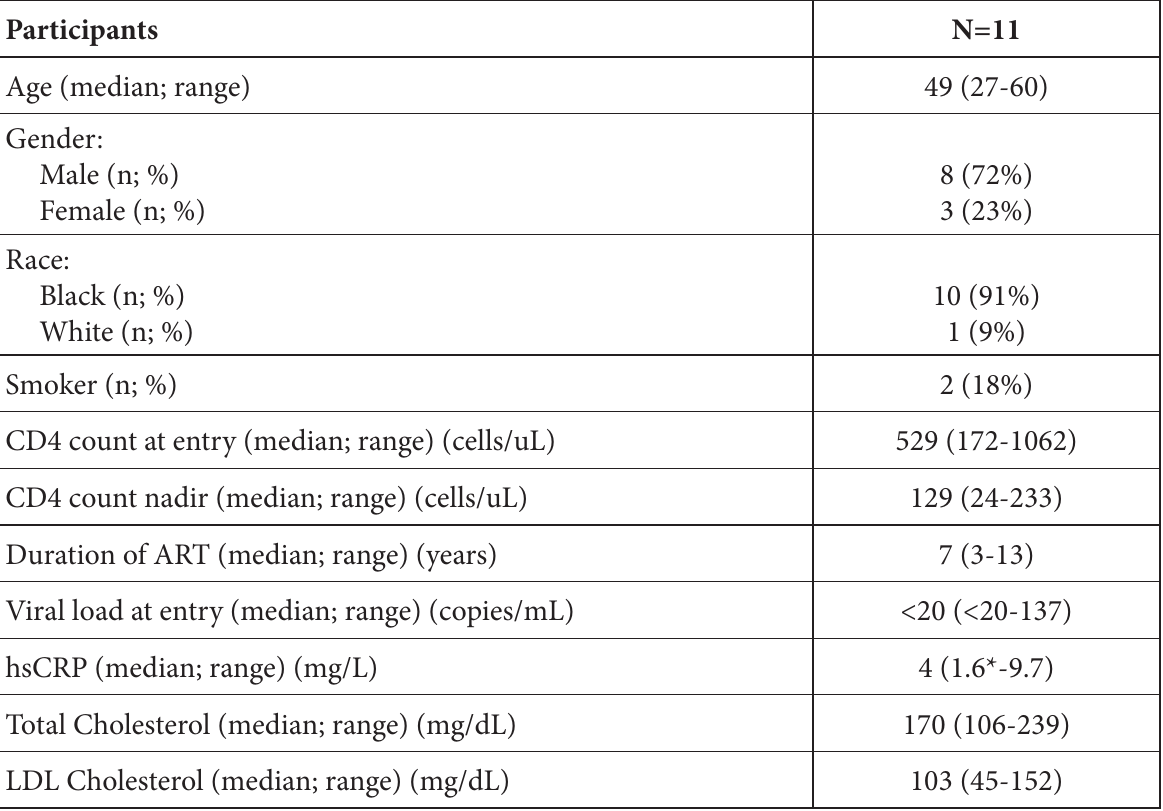
Table 1: Demographic and clinical information on participants